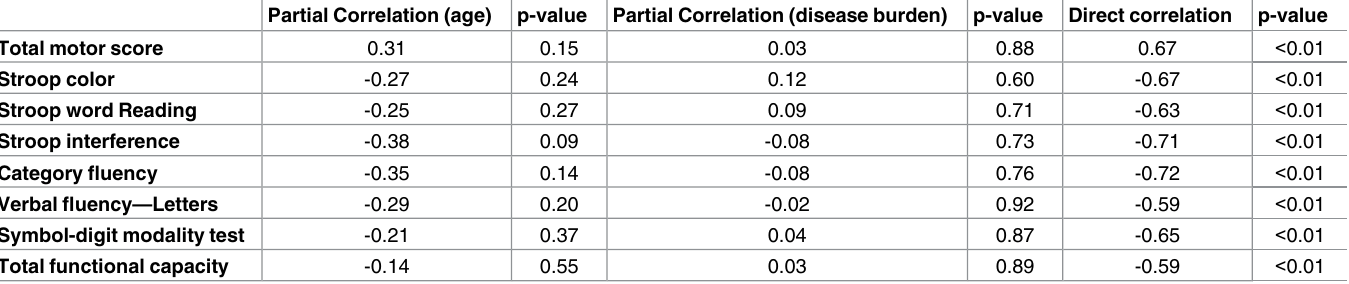
Table 3. Spearman correlations between tau and clinical test scores adjusted for age and adjusted for disease burden compared with the direct correlations. Partial Correlation